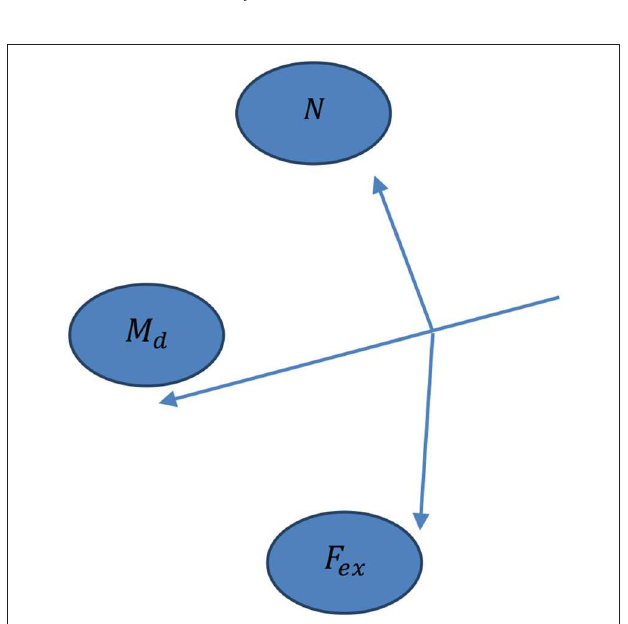
FIGURE 4 | The droplet movement direction M _ d with gravity F _ ex and normal N forces.